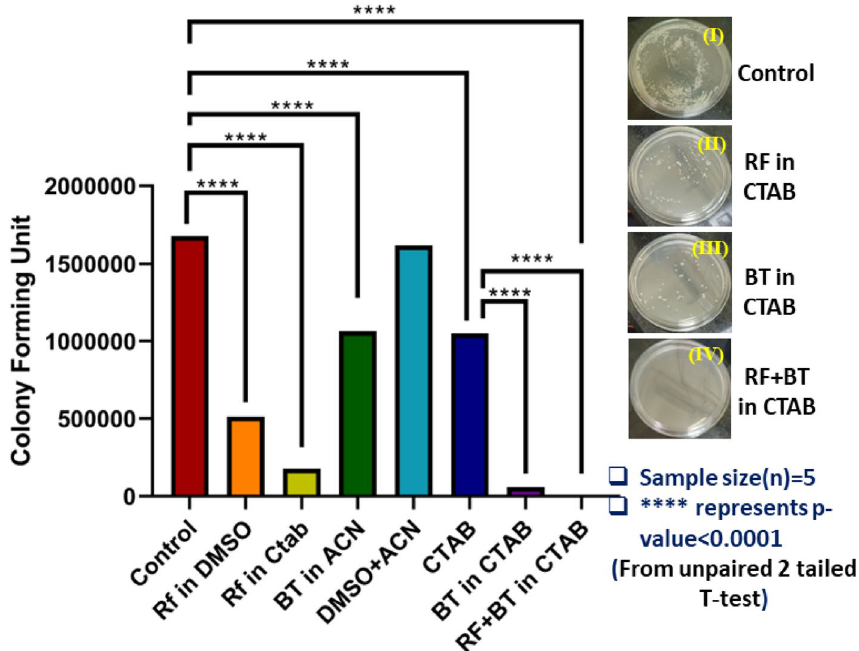
Figure 6. Bacterial viability studies after treatment with RF-BT complex in CTAB (2 units), RF in CTAB (178 units), BT in CTAB (59 units), BT in ACN (1064 units) and RF in DMSO (512 units) where the control is 1677 units. The inset shows images of MRSA culture plates for (I) Control, (II) Treated with RF in CTAB, (III) Treated with BT in CTAB and (IV) Treated with RF-BT in CTAB. The sample size is 5(n) for each group. p-value for each group is < 0.0001 as indicated by ‘****’ obtained from unpaired two-tailed T-test (see text); p < 0.05 was considered to be